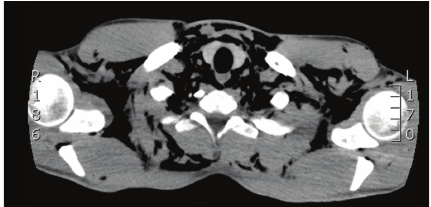
Figure 1: Axial CT image showing gross subcutaneous emphysema.